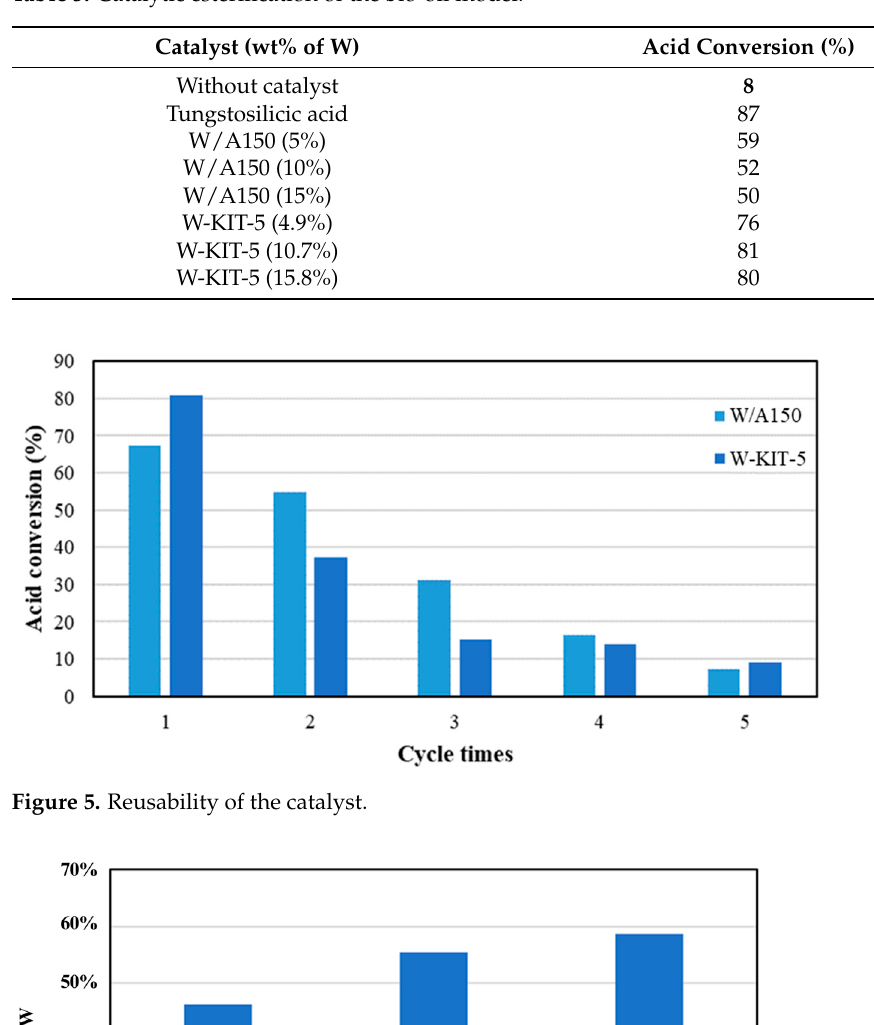
Table 3. Catalytic esterification of the bio-oil model.